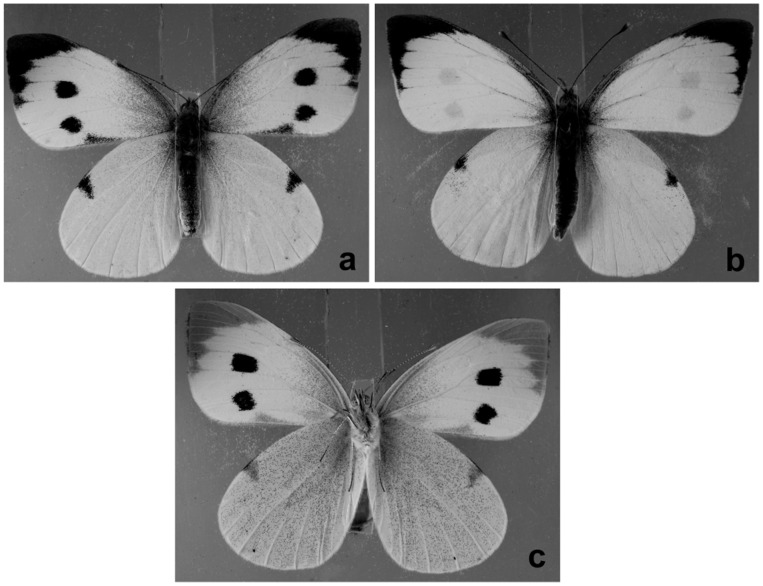
Dorsal wings of female (a) and male (b) Pieris brassicae.The colouration of ventral wings is the same for both sexes; a female is shown here (c). Total black areas of dorsal and ventral forewings were measured.